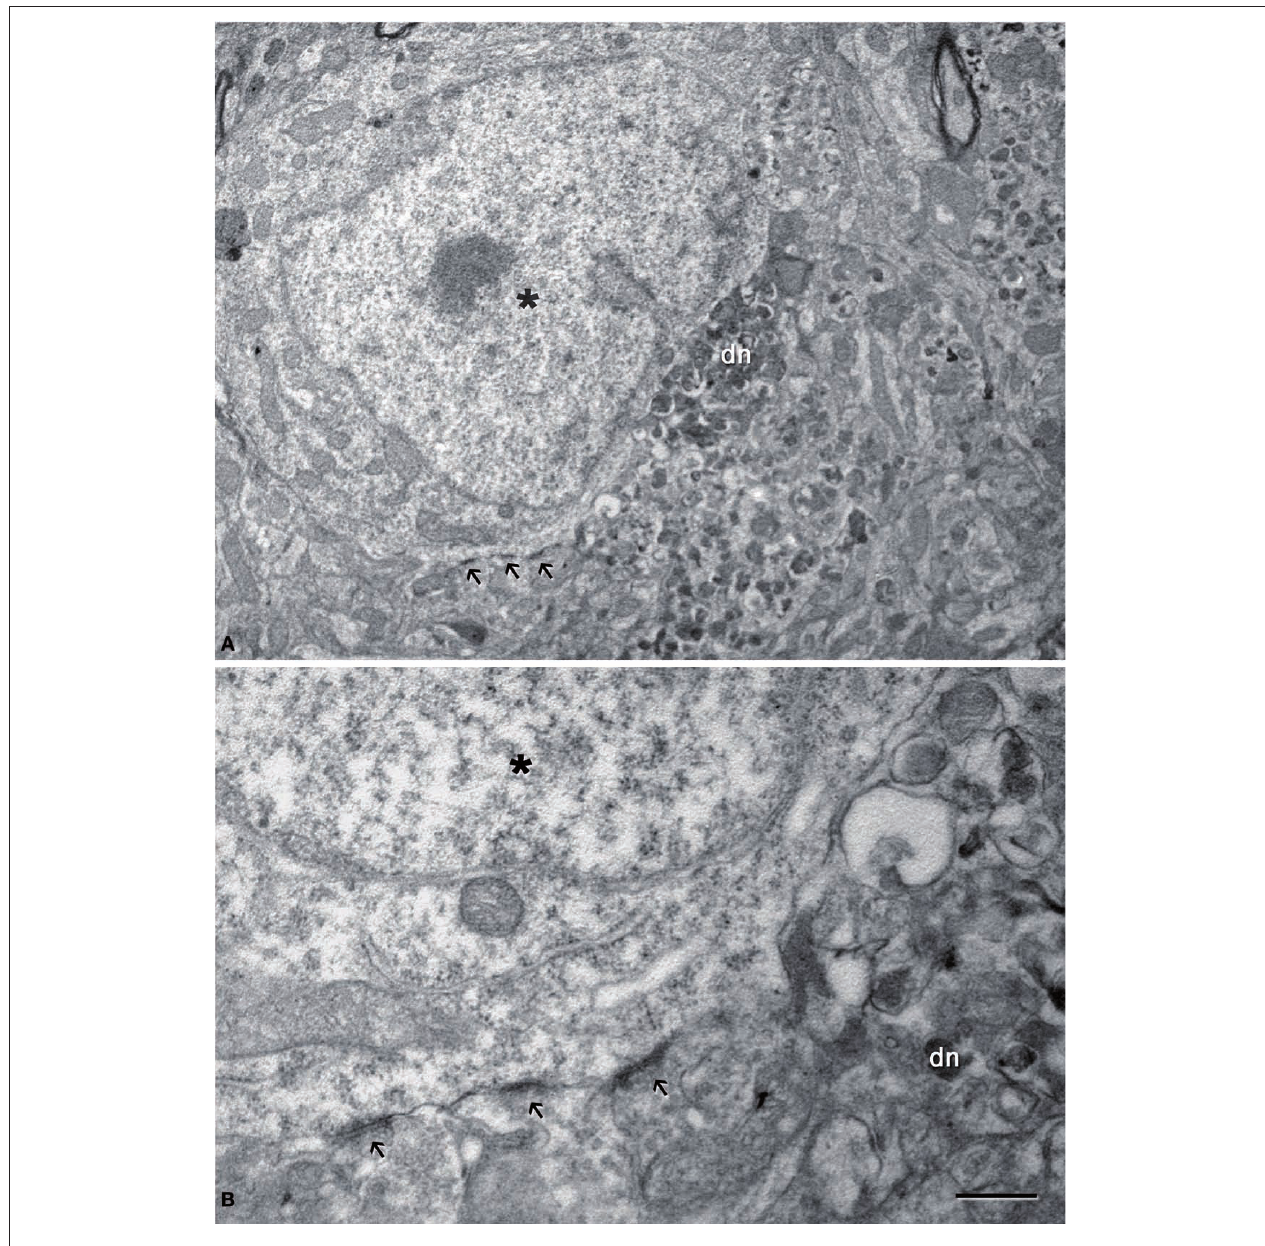
soma that is not in contact with the dystrophic neurite. (B) Higher magnifi cation of the axo-somatic synapses that are typically symmetric (GABAergic) synapses (see text for further details). Scale bar, 4 µm in (A) ; 1 µm in (B)